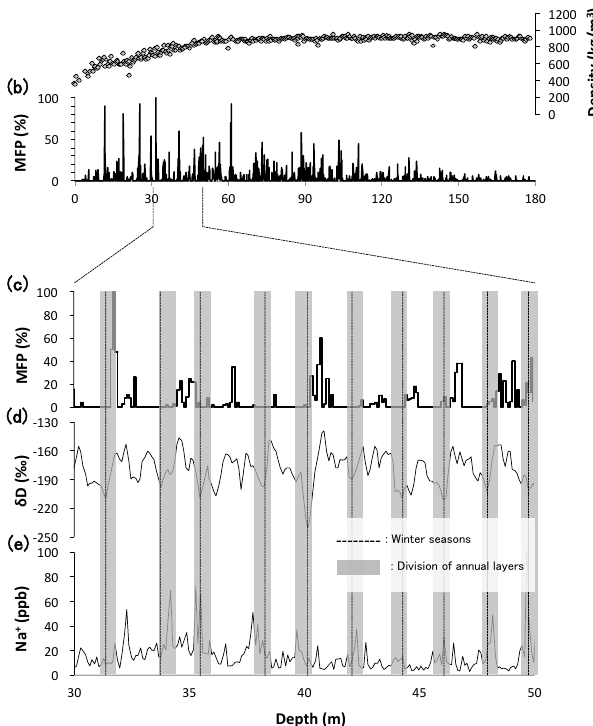
Figure 2. (a) Ice core density and (b) melt feature percentage (MFP) plotted against the snow depth scale between 0 and 180m. Then, we show the variation in snow depth scale between 30 and 50m, (c) the MFP, (d) stable hydrogen isotopes ( δ D), and (e) Na + . Gray shading indicates winter seasons. The dotted lines show the compartmental depths of the annual